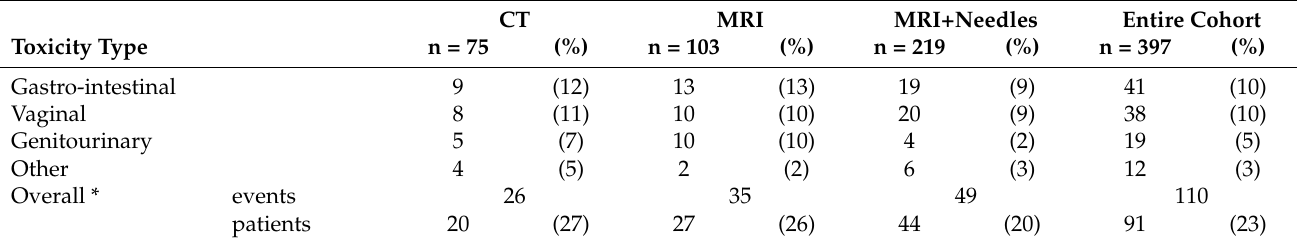
Table 3. Severe late toxicity type per treatment